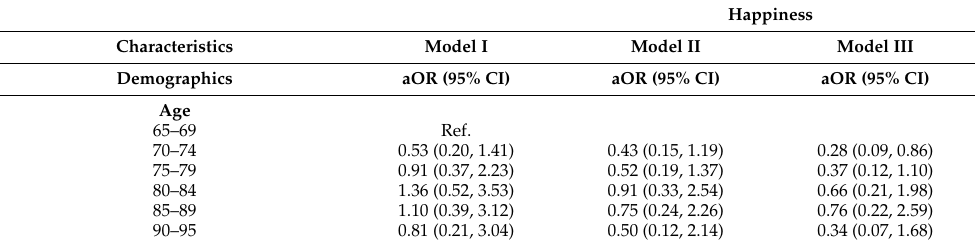
Table 5. Regression results for the happiness of care home